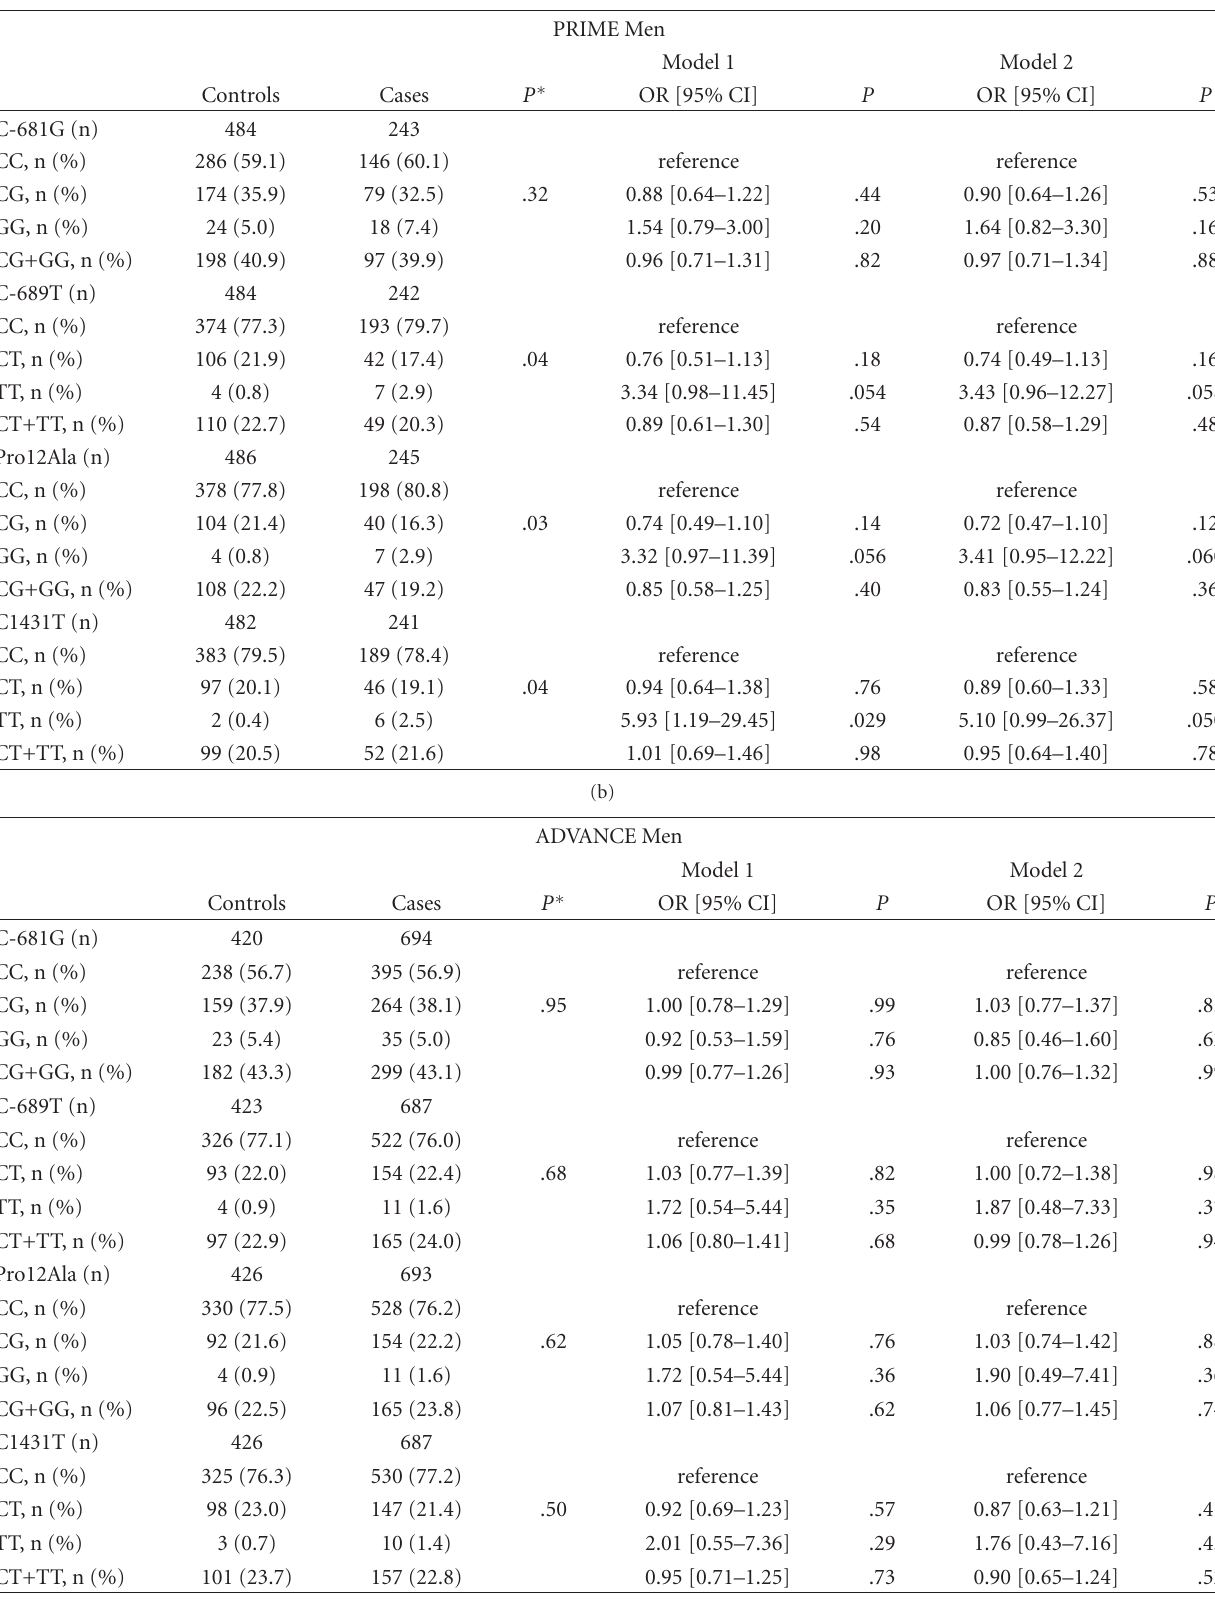
Table 2: PPARG genotype distributions among white CHD cases and CHD-free controls and ORs [95% CI] of